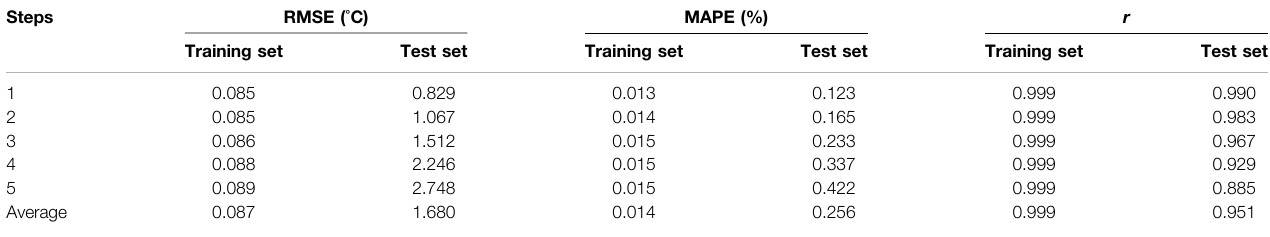
TABLE 4 | Performance of multistep prediction model based on